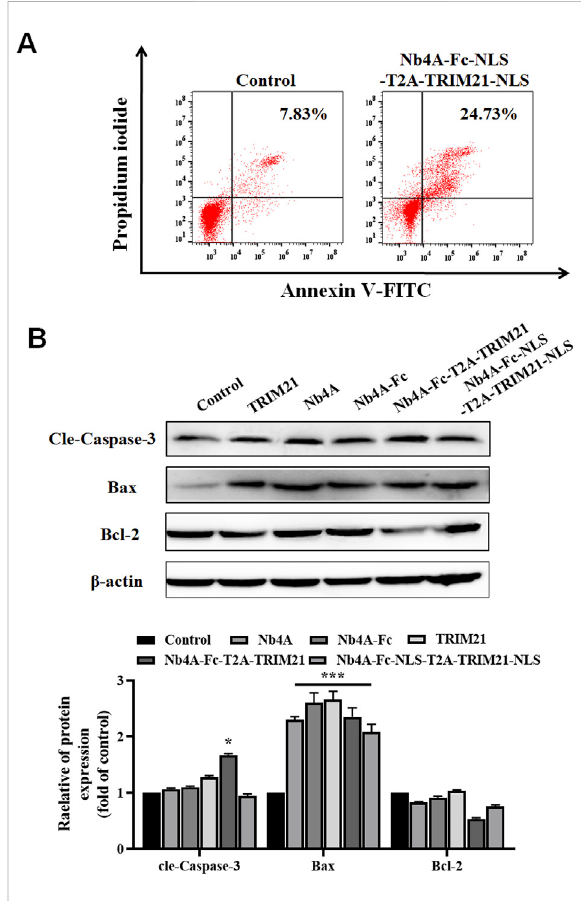
FIGURE 6 Effects of survivin degradation in different subcells on apoptosis. (A) MCF-7 cells were transfected with the recombinant plasmid Nb4A-Fc-NLS-T2A-TRIM21-NLS for 48 h. The apoptosis rate was analyzed by FC. (B) Expression levels of apoptosis- related proteins in MCF-7 cells transfected with different recombinant plasmids for 48 h. The expression of cle-caspase-3, Bax, and Bcl-2 was detected in cells. The protein bands of cle- caspase-3, Bax, and Bcl-2 were normalized to β -actin, and the results are shown below ( n = 3). * p < .05 and *** p < 0.001 versus control. Data are expressed as mean ±